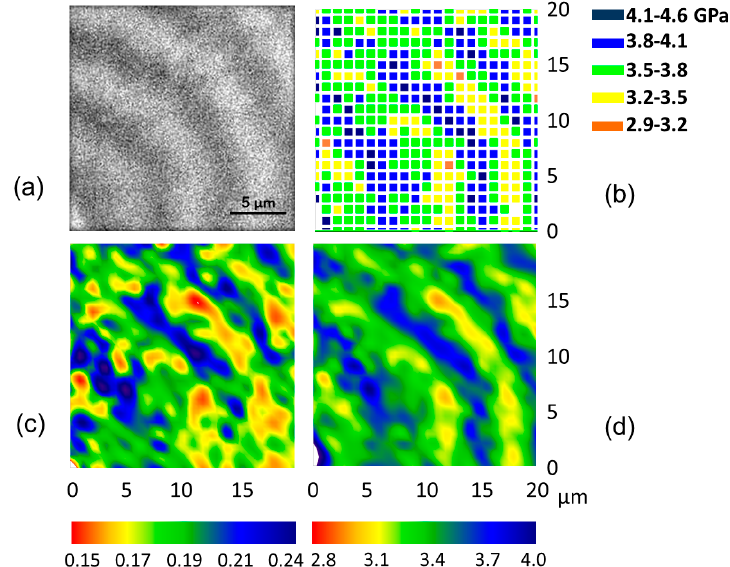
Figure 4. ( a ) Optical micrograph of the area probed using an array of 21 × 21 indentations separated by 1 µm. The spherulite center is located at (0,0); ( b ) Mesh of indentation modulus values at specific X and Y positions. The color code appears on the right-hand side of the map; ( c ) H and (d) E ′ contours, respectively, constructed by interpolating the mesh of indentation data. The color scale (in GPa) appears at the bottom of the respective plots.